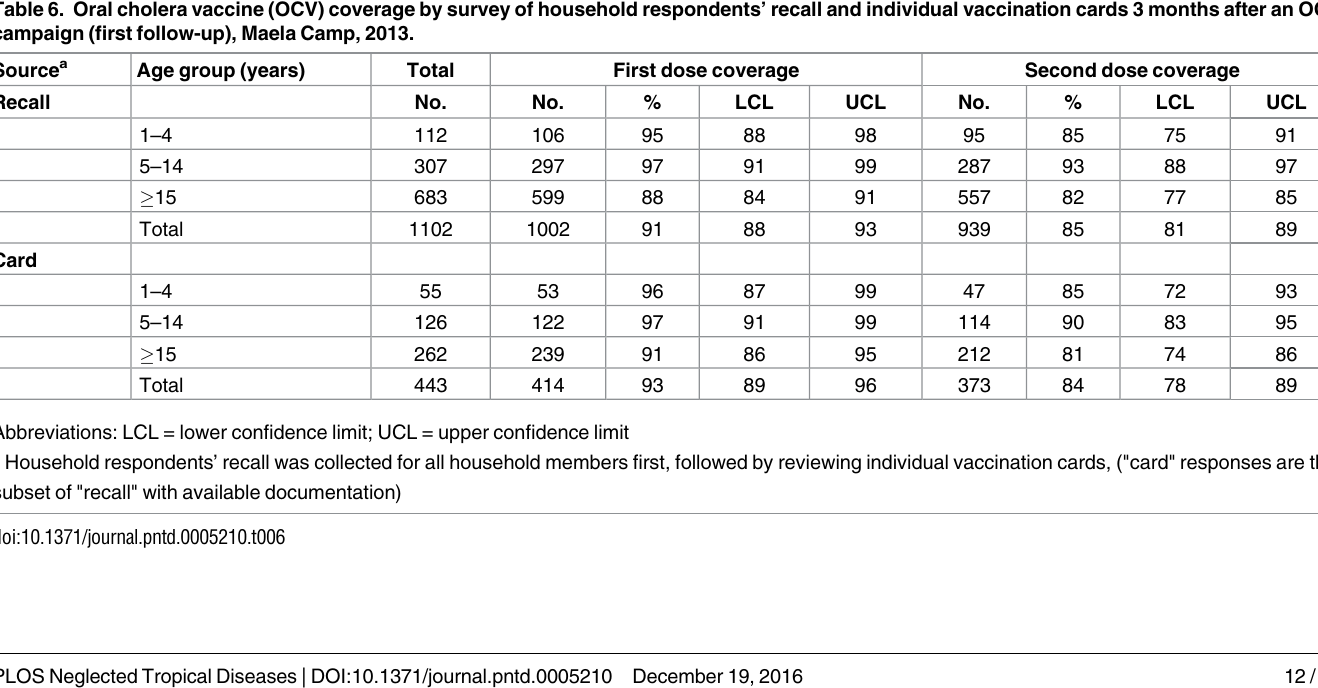
Table 6. Oral cholera vaccine (OCV) coverageby survey of household respondents’ recall and individual vaccination cards 3 months after an OCV campaign (first follow-up), Maela Camp, 2013. Source a Age group (years)